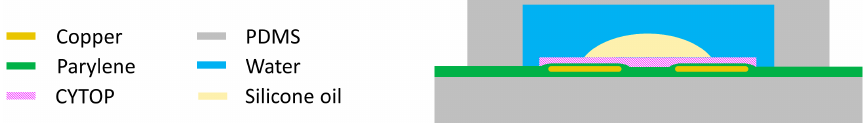
Figure 3. Cross-section of a schematic of a single, fully assembled electrowetting cell. The well for containing the liquids for electrowetting was affixed using PDMS, and a silicone oil droplet was placed over the hydrophobic region of the flexible dielectric surface defined by the patterned CYTOP before being surrounded by water and sealed into the well.